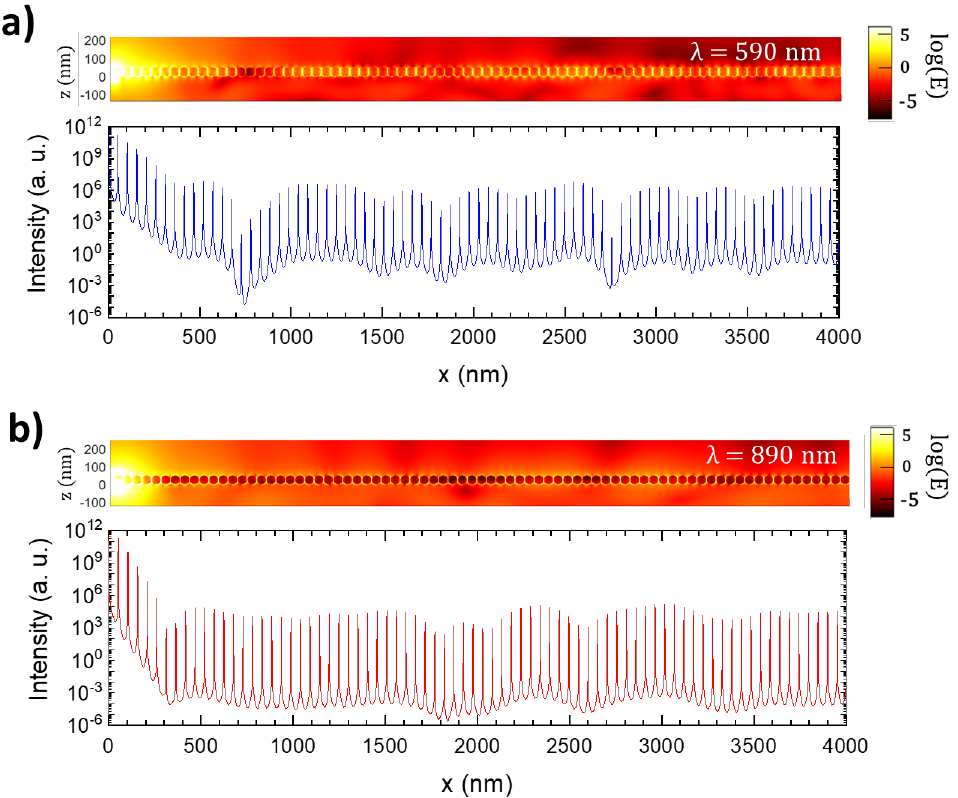
Figure 5. Computed near-field electric field distribution in a Ag NP chain generated by the oscillation of a single electric dipole located at x = 0, z = − 3 nm, that emulates an emitting ion at λ = 590 nm ( a , top) and 890 nm ( b , top). The dipole oscillates parallel to the x axis. Intensity profiles at both wavelengths along the midplane of the NPs ( z = 25 nm) are shown below in each panel.